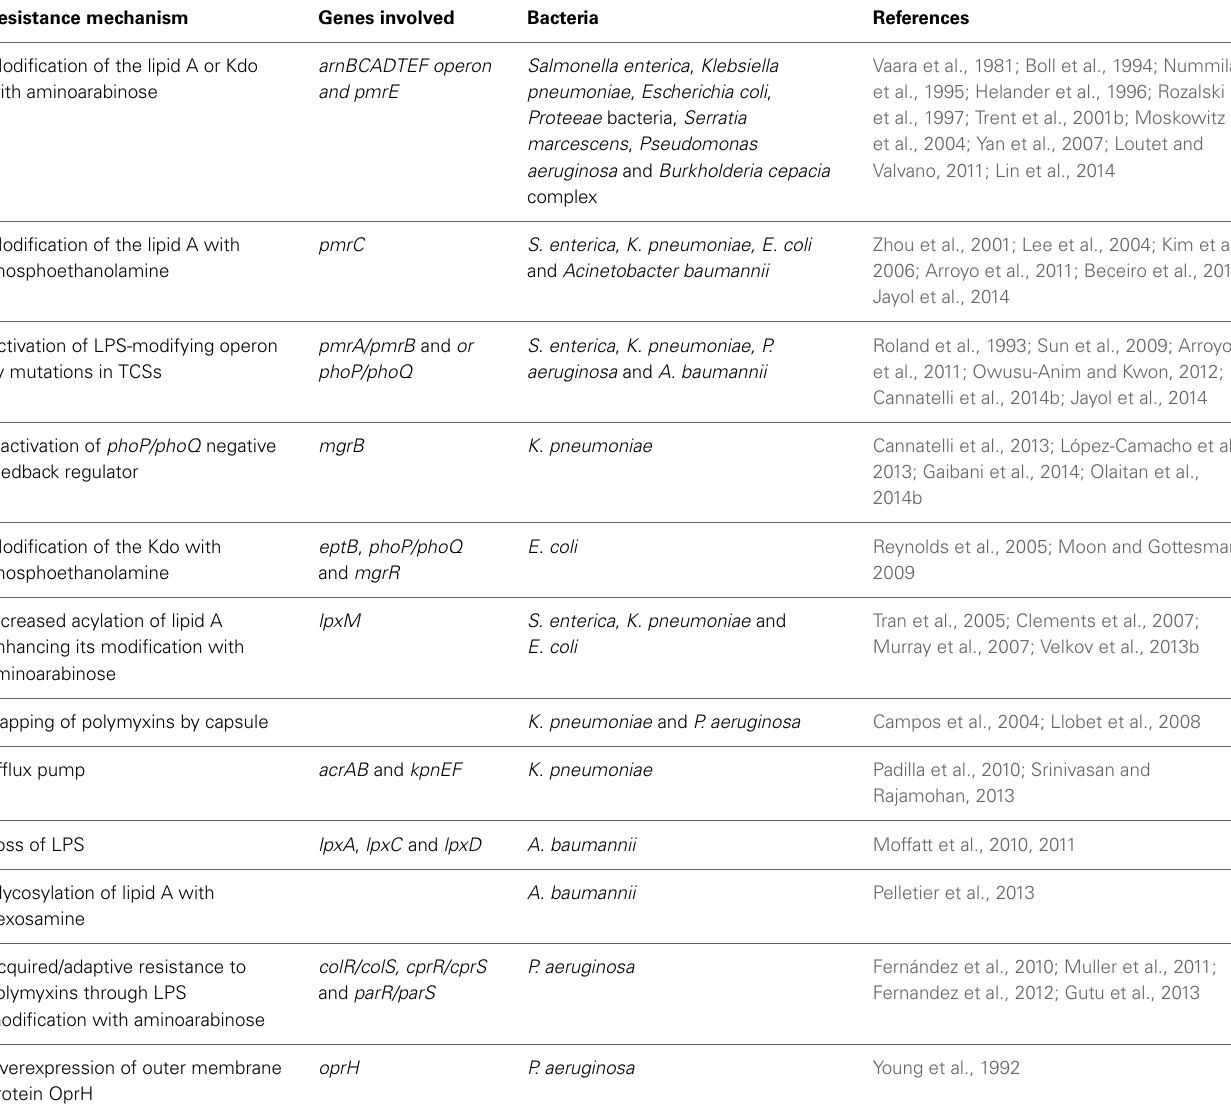
Table 2 | Strategies employed by Gram-negative bacteria for achieving resistance to